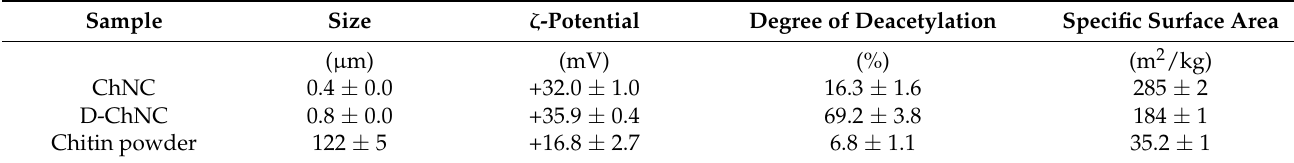
Table 1. Particle characteristics of ChNC, D-ChNC, and chitin